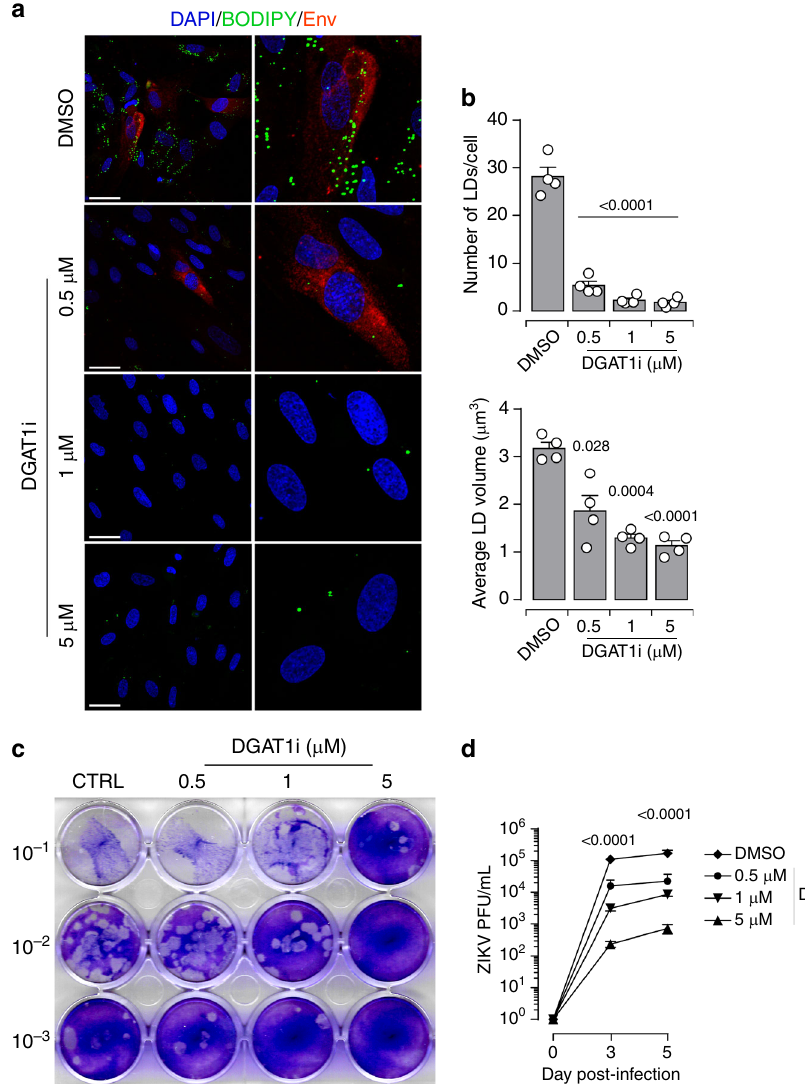
Fig. 6 DGAT1 activity and LD formation are required for ZIKV life cycle. Primary placental cells were pre-treated for 30 min with different concentrations of DGAT1i (0.5 μ M, 1 μ M, 5 μ M), then cells were infected with ZIKV MOI of 1 up to 5 days in the presence of the DGAT1i. For the control, the cells treated with the same concentration of DMSO. a After ZIKV infection, the cells were co-immunostained for with the BODIPY 493/503 dye (green), envelope group antigen (Env in red), and nuclei (DAPI in blue). High-magnitude images are shown right panel, Scale bar 50 μ m. b Quanti fi cation of LD amount per cell, the average volume of LD determined from 4 independent donors based on Z-stack projections of confocal images. Results are presented as mean values ± SEM. P -value denote comparisons between DMSO control and DTAG1i treated cells, two-tailed Student ’ s t test. c Cell-free supernatants of cultures from growth curve experiments of DGAT1 inhibition assay were collected. The supernatants were 10-fold serial dilutions and 100 μ l of diluted supernatant was incubated with Vero cells for plaque assay. d The kinetic of viral titers were determined based on plaque assay experiments. Data are presented as mean values ± SEM from three independent donors. Stars denote comparisons between DMSO control and DTAG1i treated cells. P values are computed using two-way ANOVA, with Tukey ’ s multiple comparison test. Source data are provided as a Source Data fi mock cells, the morphology of mitochondria was altered in ZIKV-infected placental cells (Fig. 8a, enlargement in the right panel).